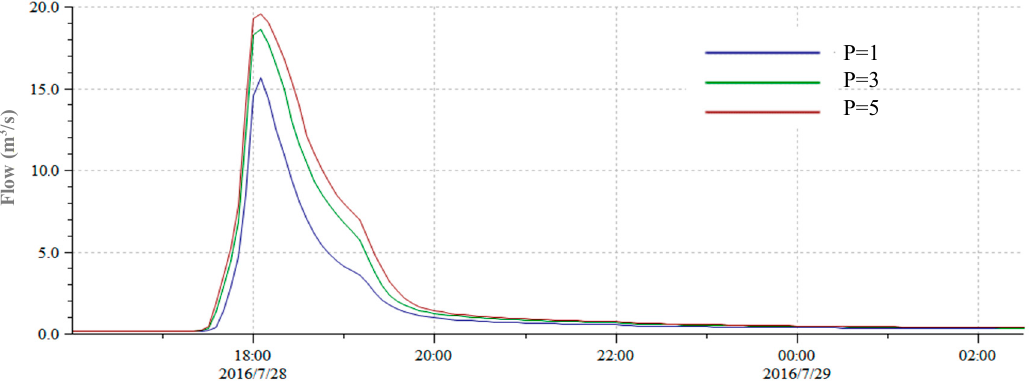
Figure 4. Discharge curves under different recurrence periods. Table 5. Total flow and pollutant discharge of intercepting manholes under different recurrence intervals.